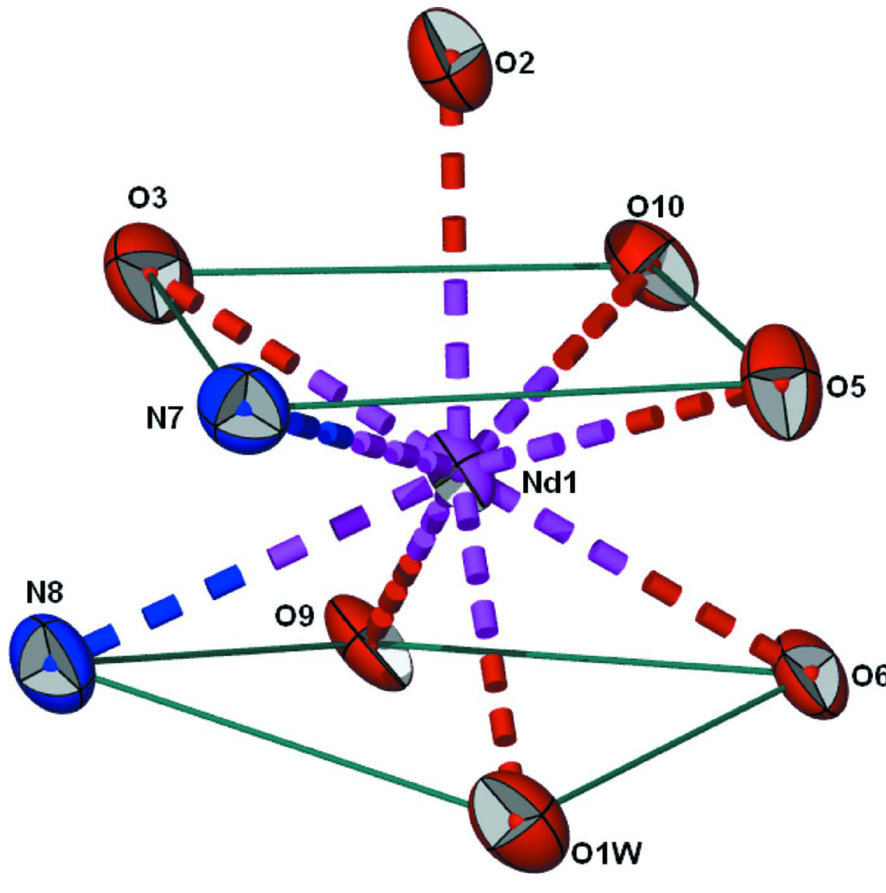
Figure 2 Geometry of